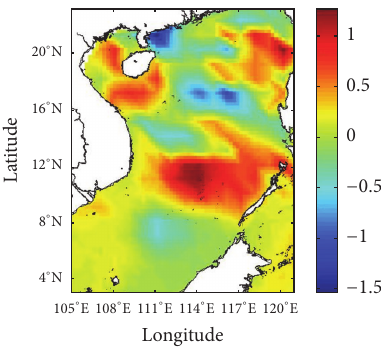
Figure 11: Spatial trend in 100-year return period, 99th-percentile wave height calculated using linear regression from the extreme valueanalysisofthesegments(periods)fortheSCS. Note. Thevalues on the side bar are in mdecade −1 .